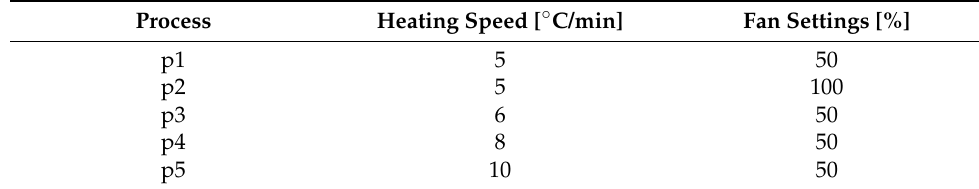
Table 2. Parameters of heating processes.